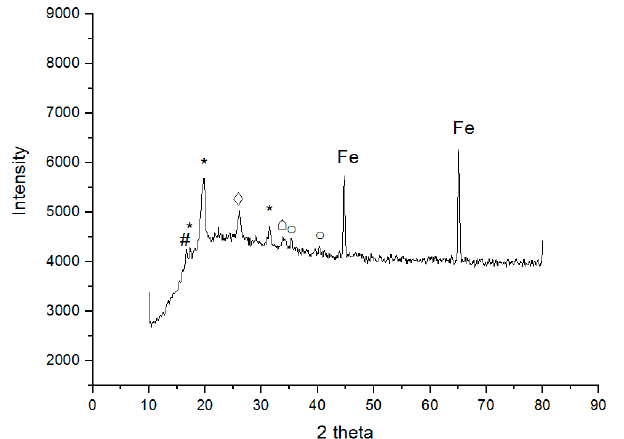
Figure 10. Diffractogram of a white coating from a phosphating solution with the addition of zinc nitrate.